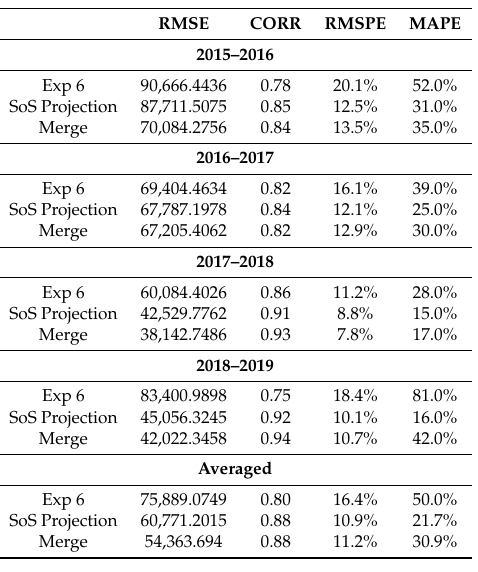
Table A1. Detailed metrics for each season from 2015 to 2016. RMSE CORR RMSPE MAPE